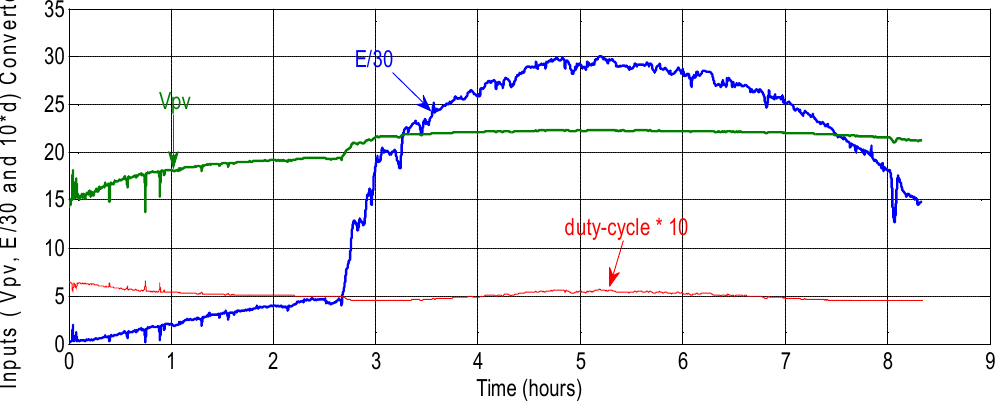
Figure 17. Inputs (d, Vpv, and irradiation) vs. time.